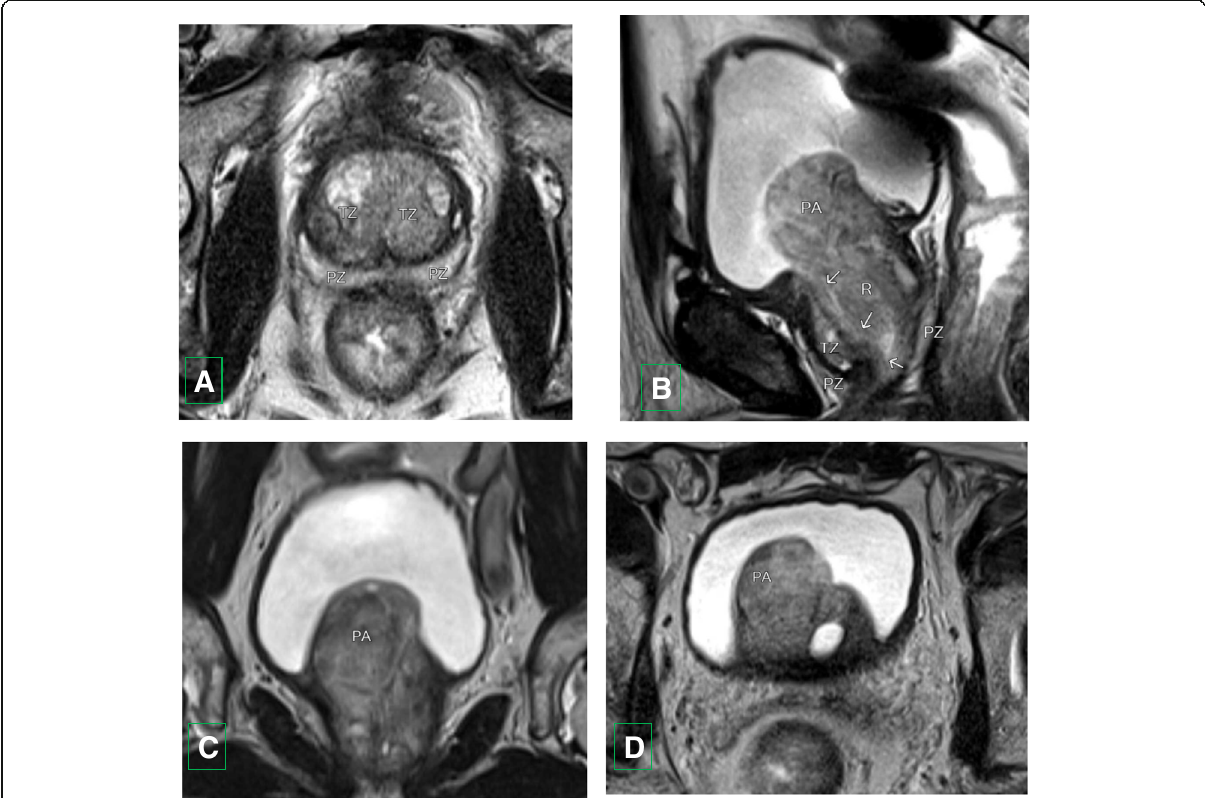
Fig. 7 Seventy-three years old man type 5 BPH. a Axial T2 WI showing bilateral transition zone (TZ) (lateral lobe) enlargement. Peripheral zone (PZ) is noted. b Sagittal T2 WI showing pedunculated adenoma (PA) protruding into the bladder base. Retrourethral (median) lobe enlargement (R) along the posterior aspect of the prostatic urethra (arrows). c Coronal and d axial T2 WI showing pedunculated adenoma (PA) protruding into the bladder